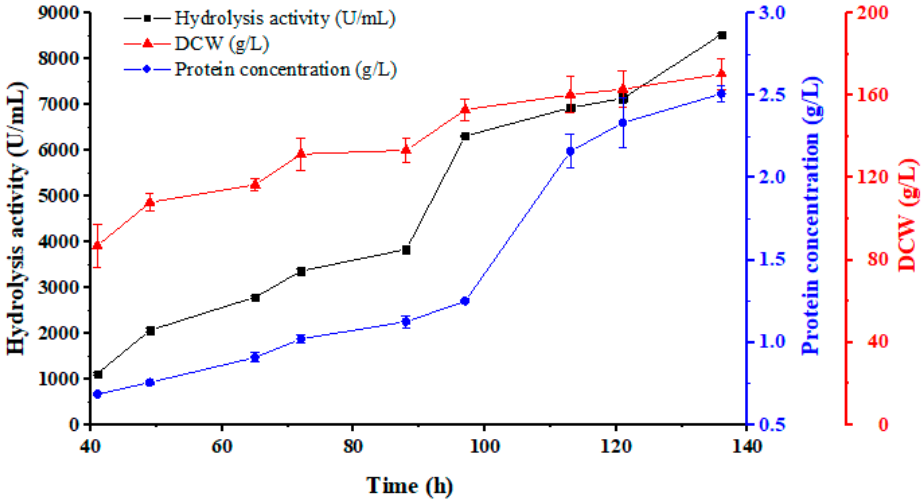
Figure 4. Time course of lipase hydrolysis activity ( (cid:4) filled square), DCW of biomass ( (cid:78) filled triangle), and total protein concentration ( • filled circle) in a 100 L fermenter with 45 L initial modified FM22 medium of the best engineered Y. lipolytica strain during fed-batch fermentation. Raw glycerol was used as the sole carbon